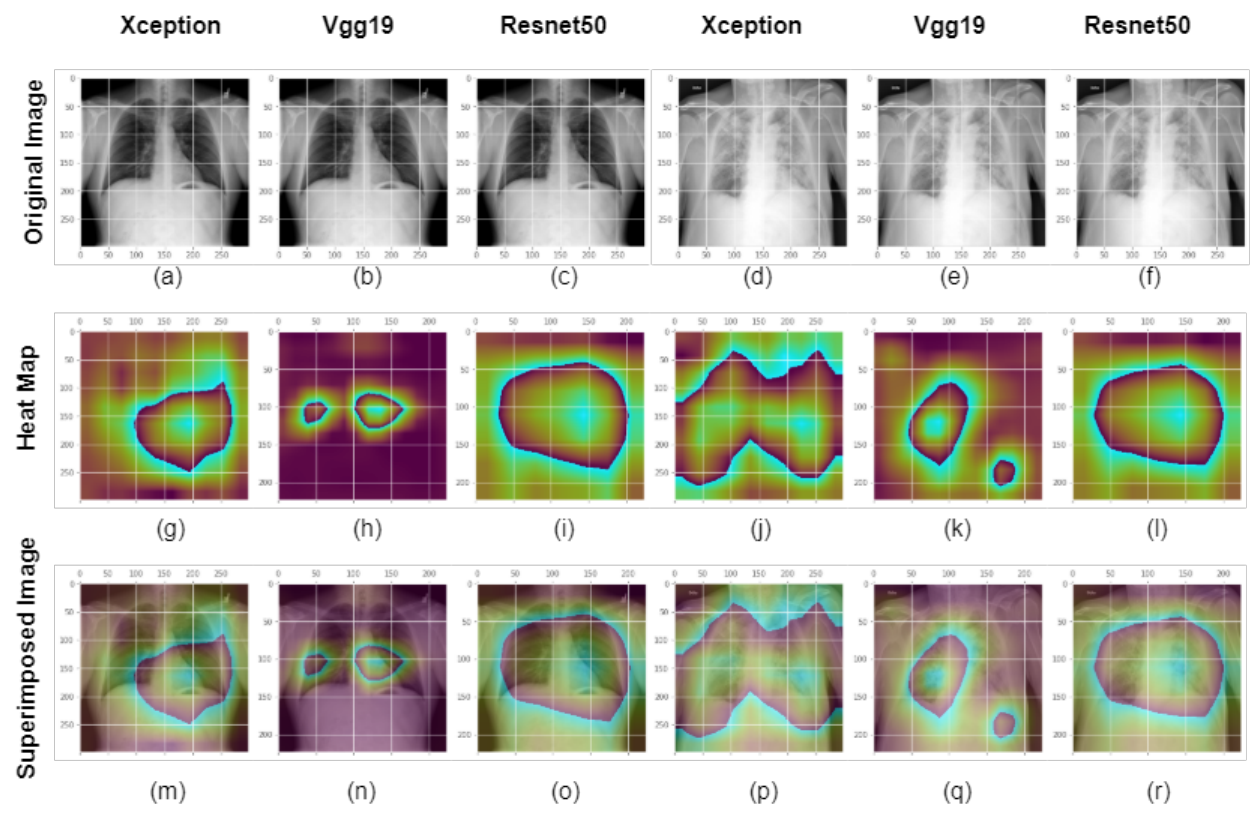
Figure 16. GradCam assessment of COVID and normal class images at the final convolution layer in the Xception, VGG19, and Resnet models. An X-ray image of the chest from the COVID class is depicted in the first row or in images ( a – f ). Images ( g – l ) or the second row depicts the GradCam activation mapping for the X-ray picture. Third row or images ( m – r ): An activation map with an X-ray image overlaid to display the superimposed image. The original picture, heatmap, and overlay image from the final convolution layer of the Xception, VGG19, and Resnet50 models for a normal class image are shown in the first three columns. For a COVID class image, the final convolution layer of Xception, VGG19, and Resnet50 is shown in the last third column along with the original picture, activation mapping, and overlay image. The final convolution layers for the Xception, VGG19 and Resnet models are block14 sep conv 2, block5 conv 4 and conv5 block 3_3 conv